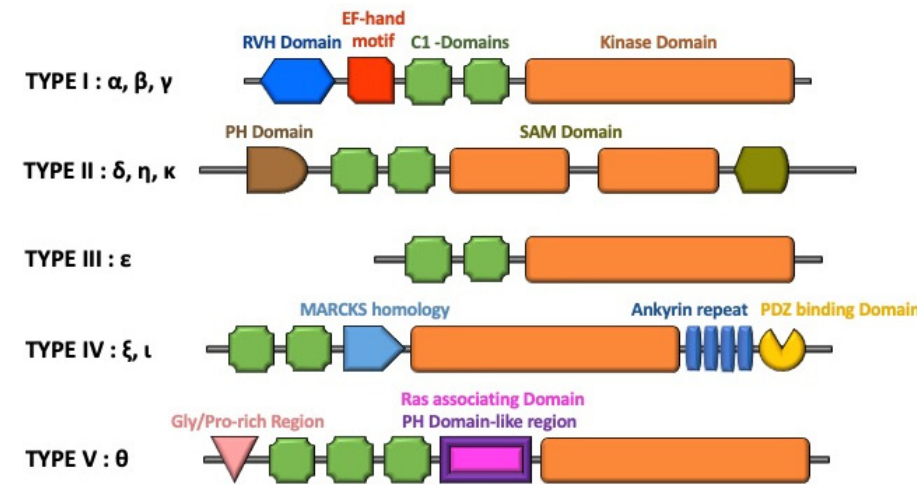
Figure 2. The structures of DGKs. DGK isoforms are classified into five types. Gly / Pro, glycine / proline; PH, pleckstrin homology; RVH, recoverin homology domain; MARCKS, myristoylated alanine rich protein kinase C substrate phosphorylation site; SAM, sterile alpha motif.